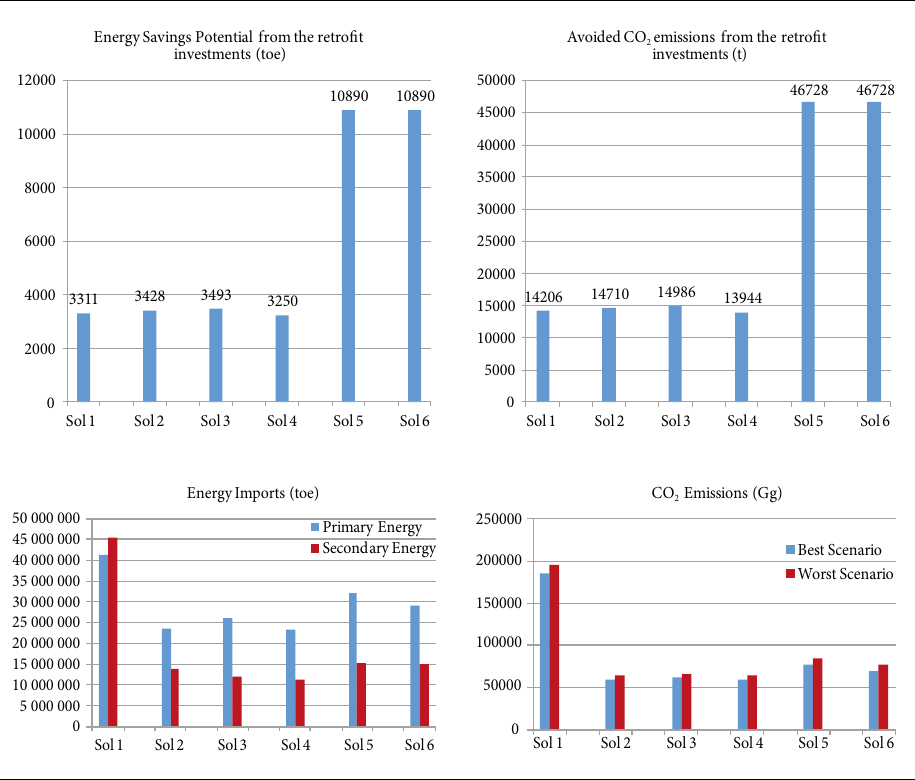
Fig. 4. Expected energy and environmental